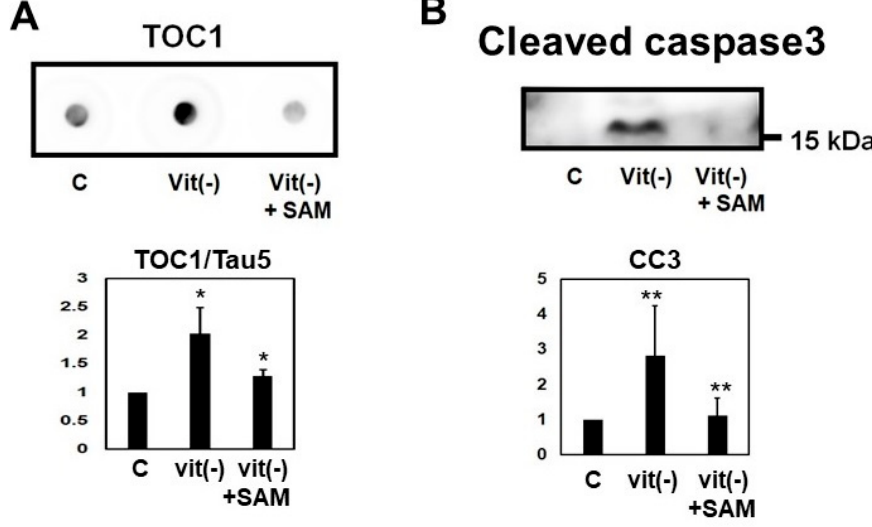
Figure 11. Induction of hyperhomocysteinema (HHCy) in P301L mice increased tau oligomerization, an effect reversed by S-adnosylmethionine (SAM) supplementation. The P301L mice fed with vitamin B 6 , B 12 , and folate-deficient chow (Hcy-diet), which is known to induce HHCy, exhibited increased of levels of oligomeric tau shown by dot blot analysist ( A ). Cleaved caspase 3 was also increased in HHCy mice ( B ). Oligomeric tau and cleaved caspase were reversed by the addition of SAM to the Hcy-diet ( A , B ). Results are presented as mean ± SD, ** p < 0.01, * p < 0.05. N = 5. C mice fed with control